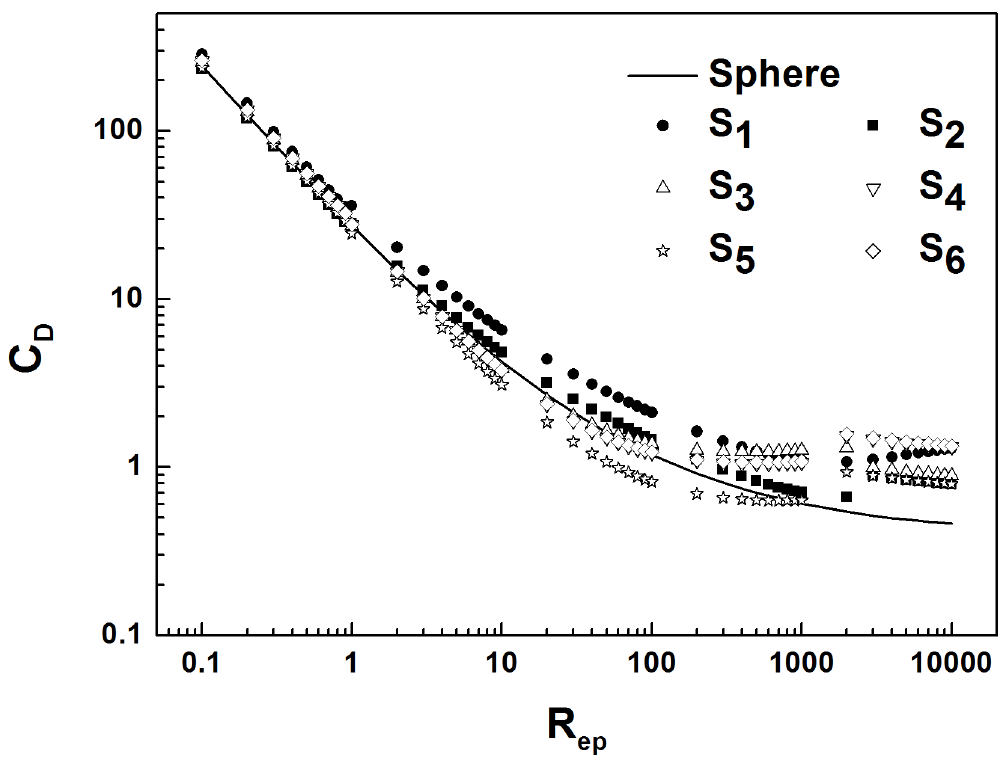
Figure 2. The drag coefficient of sand particles as a function of the Reynolds number. The relationship of the drag coefficient of sand grains of different shape to the Reynolds number is shown. Here, the black solid line indicates spherical sand grains, S 1 and S 2 are two different ellipsoid-shaped sand particles, S 3 represents cube-shaped sand particles, S 4 and S 5 represent two types of cylinder-shaped sand particles, and S 6 represents frustum-shaped sand particles.